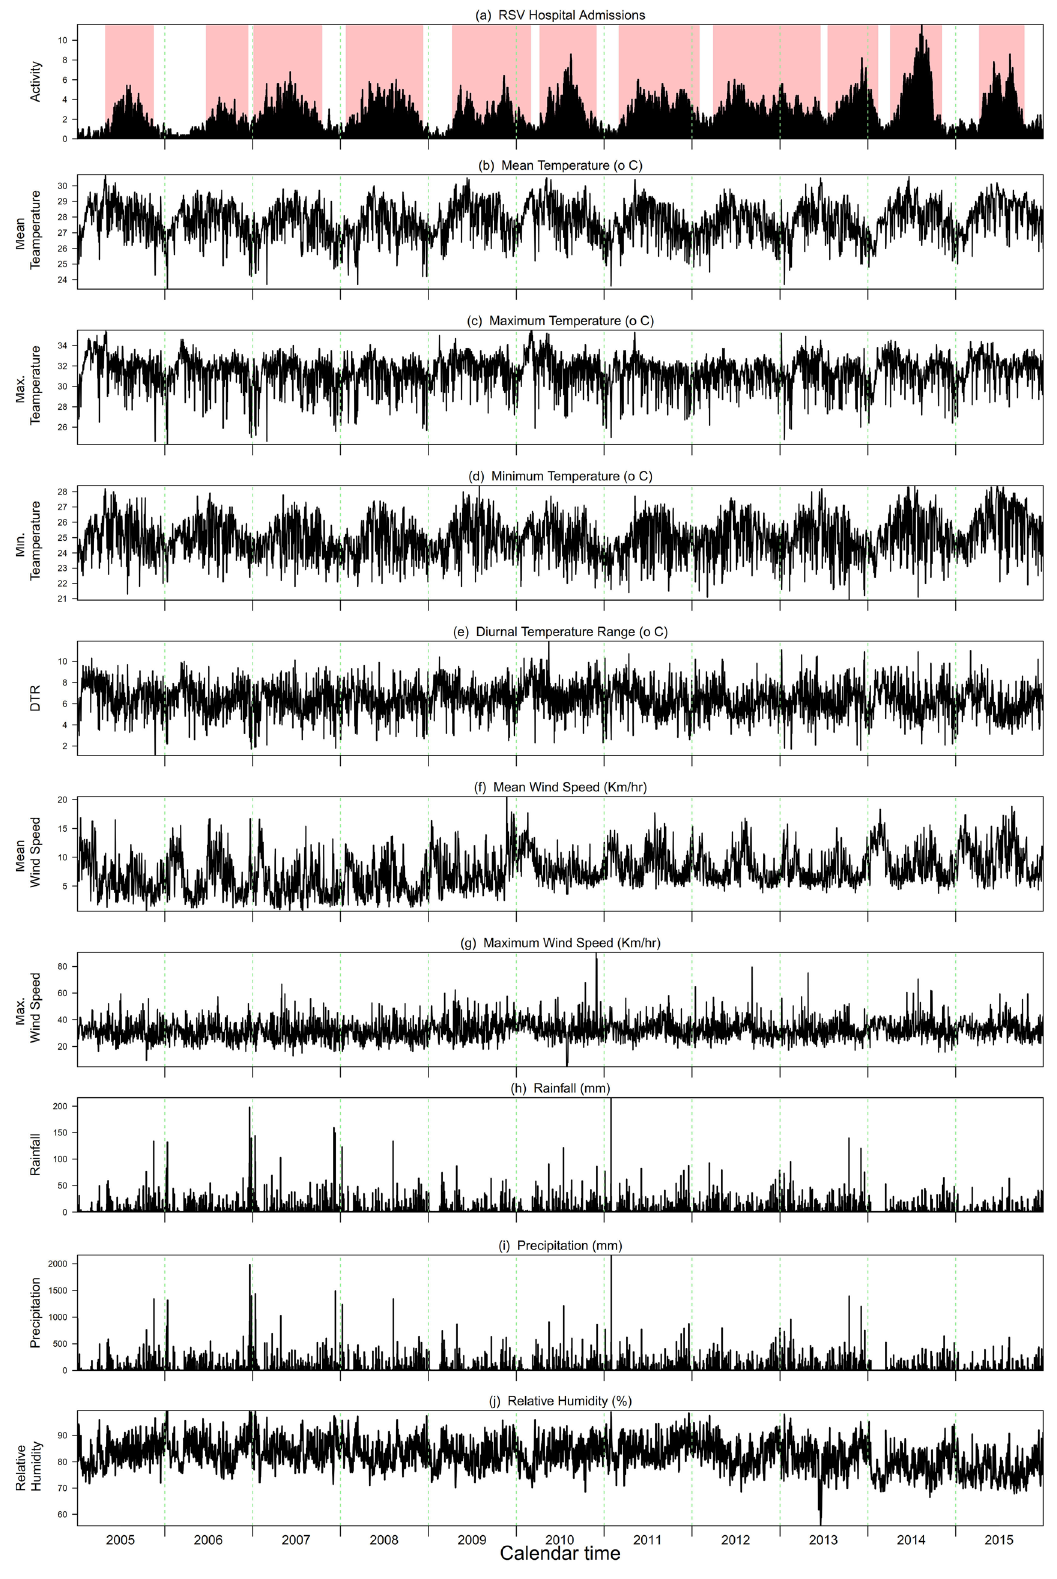
Figure 1. ( a ) Daily activity of RSV hospital admissions (black bars) along with the 11 predefined epidemics (light red bars); ( b – j ) the meteorological drivers in Singapore from 2005 through